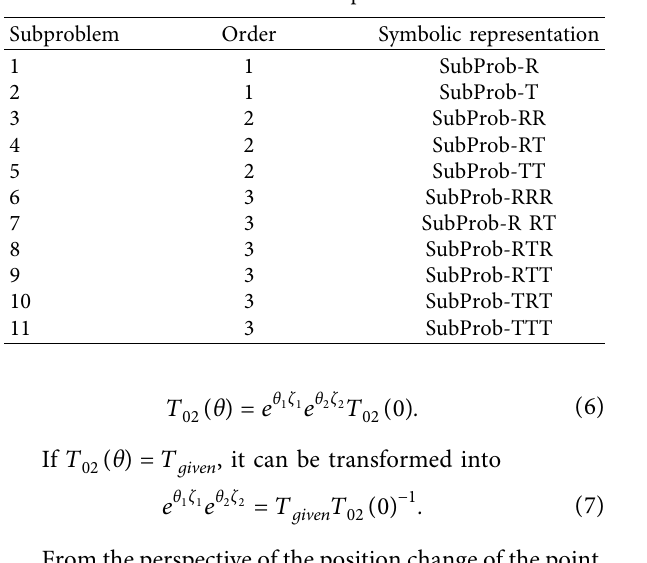
Figure 4: Schematic diagram of redundant degrees of freedom